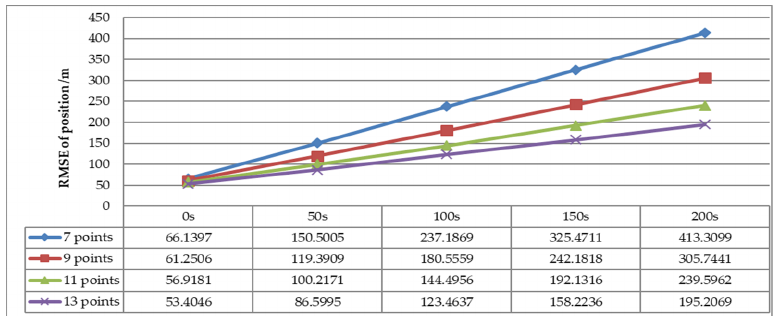
Figure 14. RMSE of predicted position versus different prediction time (Scenario 1, e P = 1 e P ).